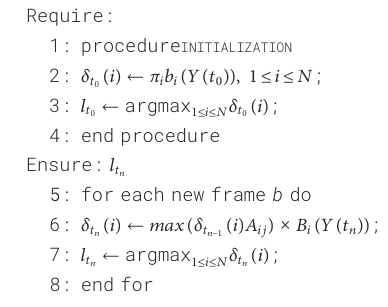
Algorithm 1. A study performed by Mannini and Sabatini, however, found that this Viterbi decoding alternative is plagued by erroneous events that consist of missed and additionally detected gait strides Mannini and Sabatini